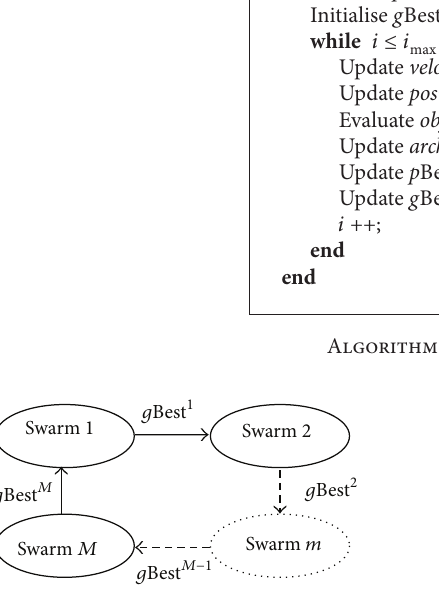
Figure 2: The best position found by the swarms, shared between all